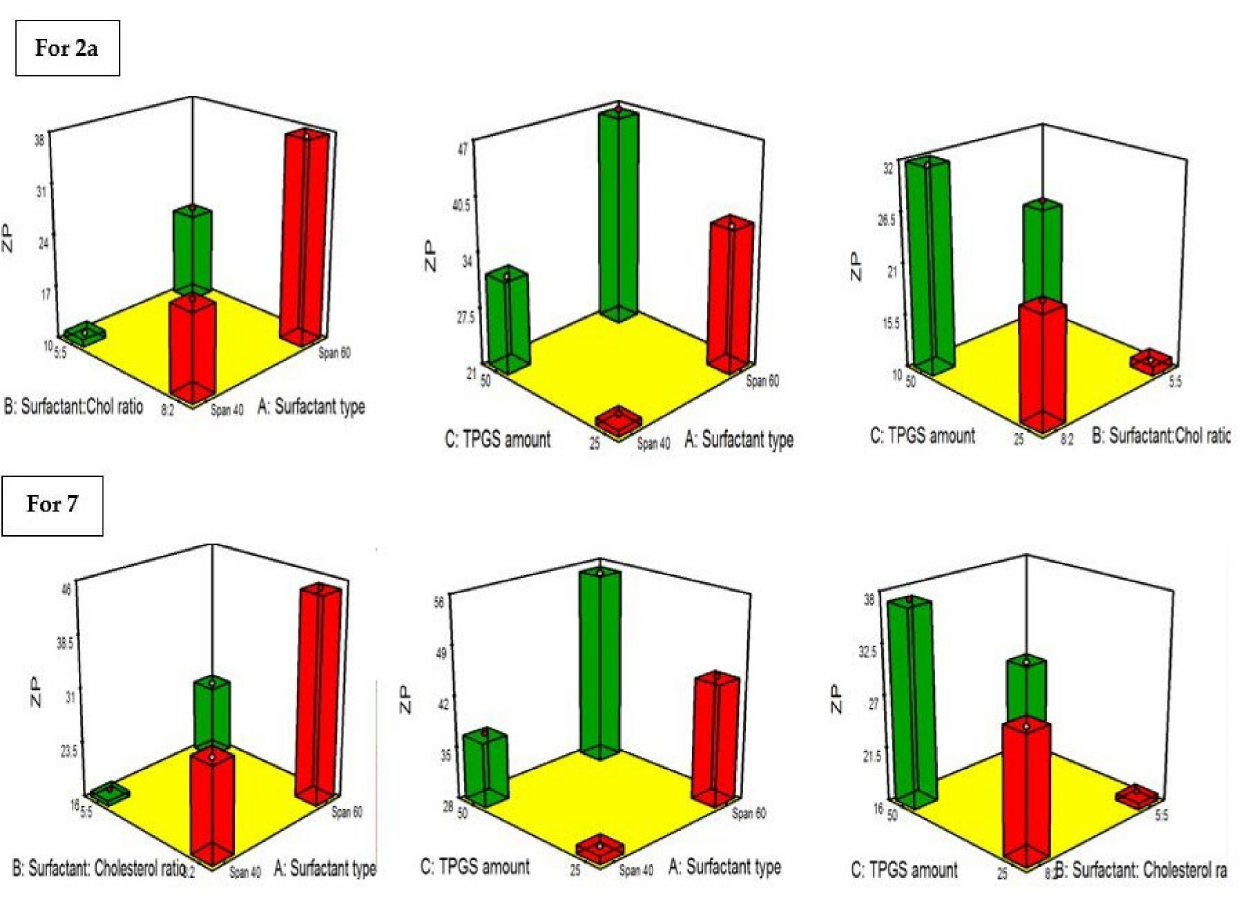
Figure 16. 3D surface response plots exploit the impact of ( A ) surfactant type, ( B ) surfac- tant:cholesterol ratio, and ( C ) TPGS amount on ZP of 2a and 7 -loaded TPGS-coated